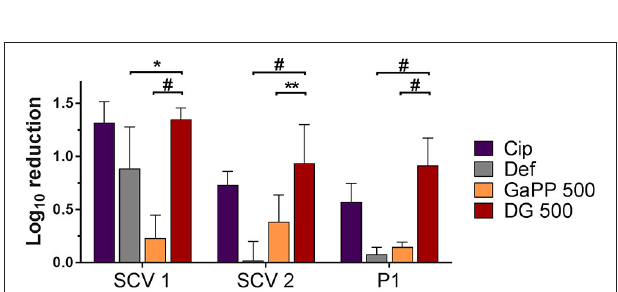
FIGURE 6 | Effects of hydrogels in an artificial wound model compared to untreated control. Log 10 reduction of small colony variant SCV1, SCV2, and parent strain P1 after exposure to hydrogels loaded with ciprofloxacin 5 µ g/ml (purple), deferiprone 20 mM (Def, gray), gallium-protoporphyrin 500 µ g/ml (GaPP, orange), and Def-GaPP500 (red). Data represent the mean ± SD of three biological replicates. * p < 0.05; ** p < 0.01; # p < 0.0001.